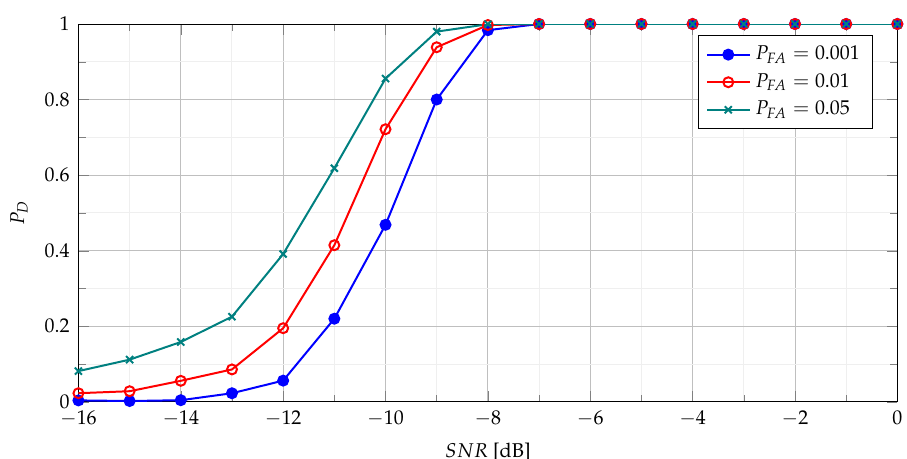
Figure 5. Probability of detection with use of the TSCPF statistics employing slices n =